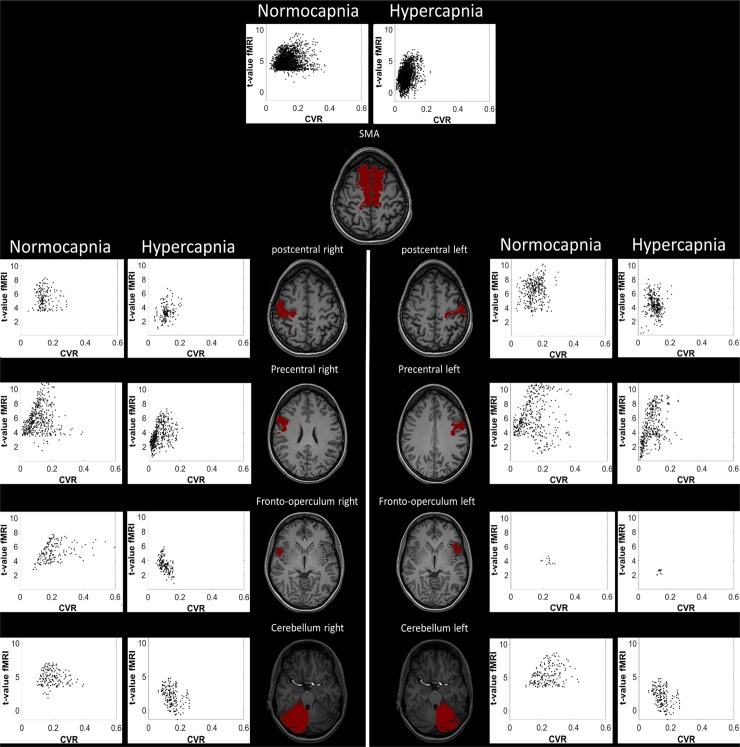
Scatterplot of the voxel-wise t-value of the task-evoked fMRI (y-axis) and BOLD CVR data (x-axis) for an illustrative subject.For each ROI, only the voxels which were significantly activated in at least one of the two finger-tapping fMRI data are plotted. The drop in t-values from normo- to hyper-capnia below the threshold (here 3.43) is clearly visible. This is known as false negative activation, implying the limitation of the task-evoked fMRI by the remaining BOLD-CVR, especially with a fixed threshold.